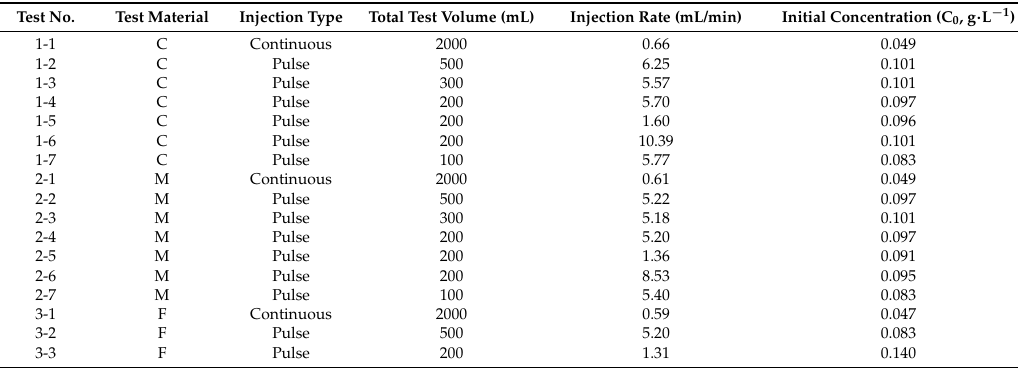
Table 1. Tracer test conditions applied to